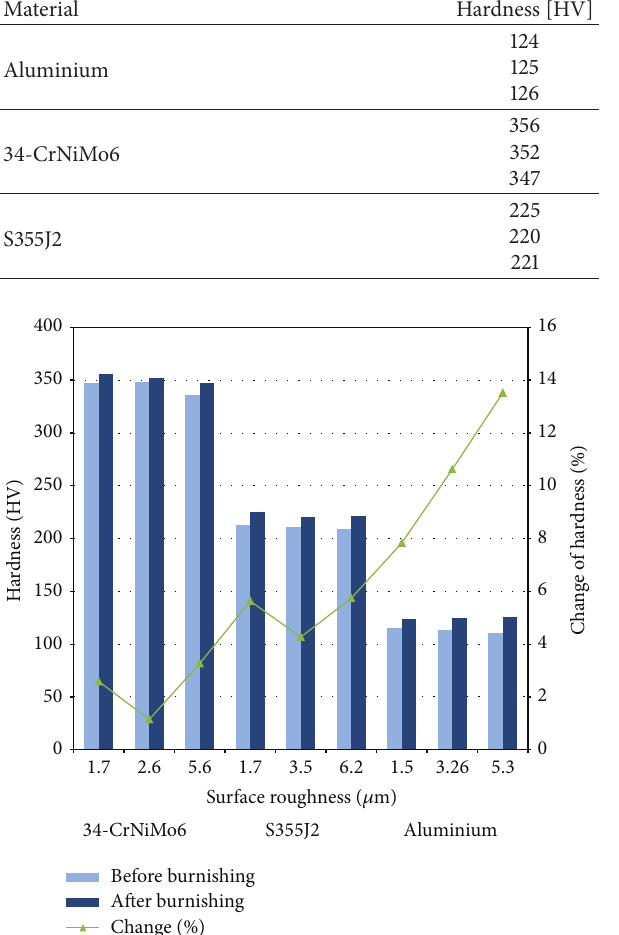
Table 2: Surface roughness results.